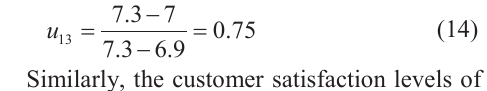
Table 8. PRPs of all products in the market segment